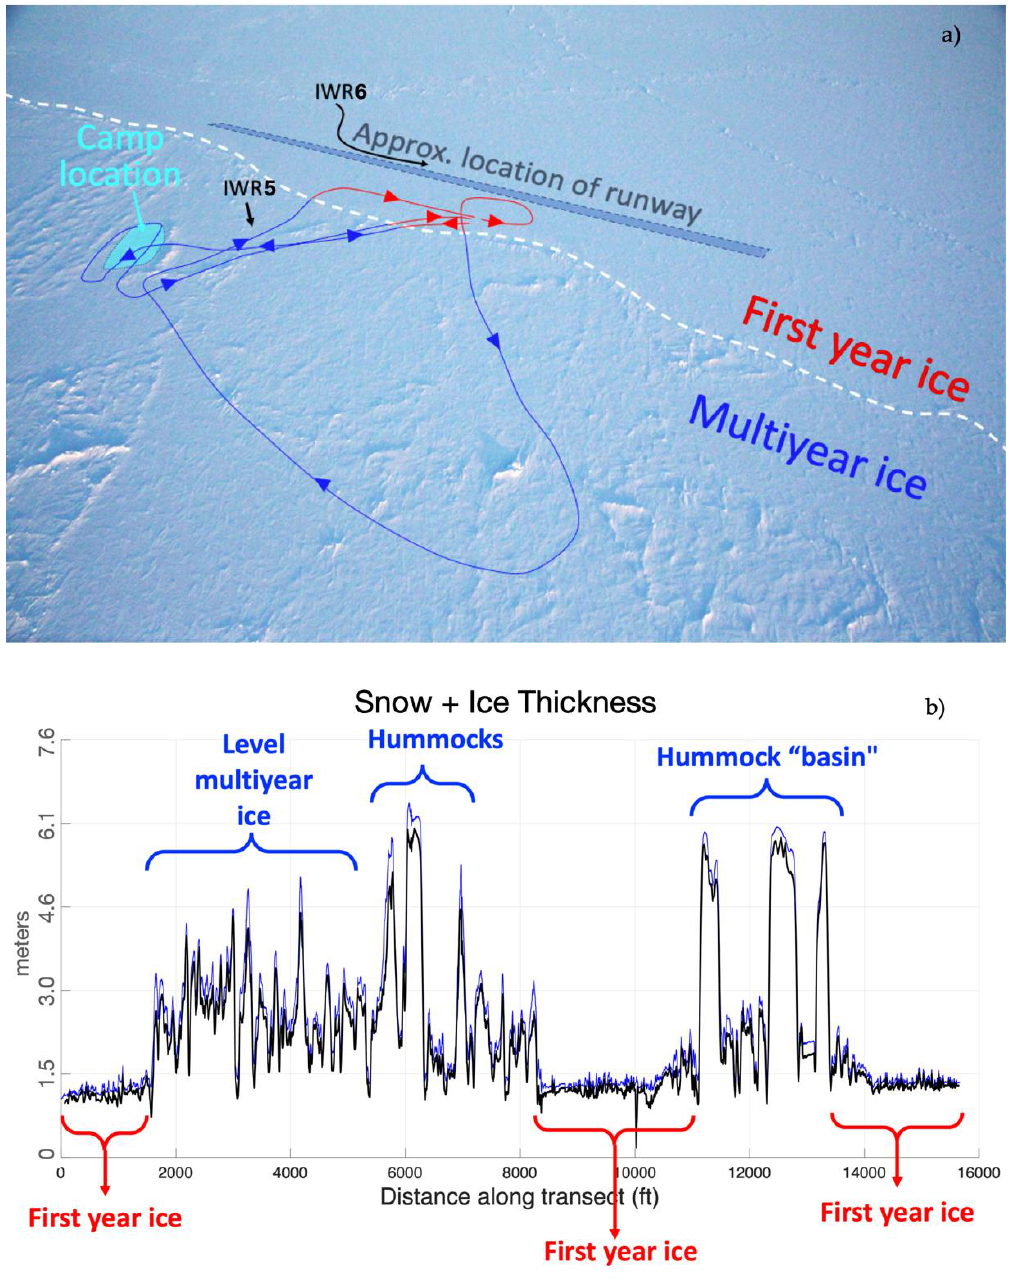
Figure 3. ( a ) ICEX2020 Camp Seadragon with electromagnetic conductivity meter (EM-31) survey lines, runway, and sensor locations. IWR6 was deployed near the runway on first-year ice and IWR5 was deployed on multi-year ice. The figure is oriented with south at the top. ( b ) Ice + snow thickness from the EM-31 repeated survey lines (blue and black colors).